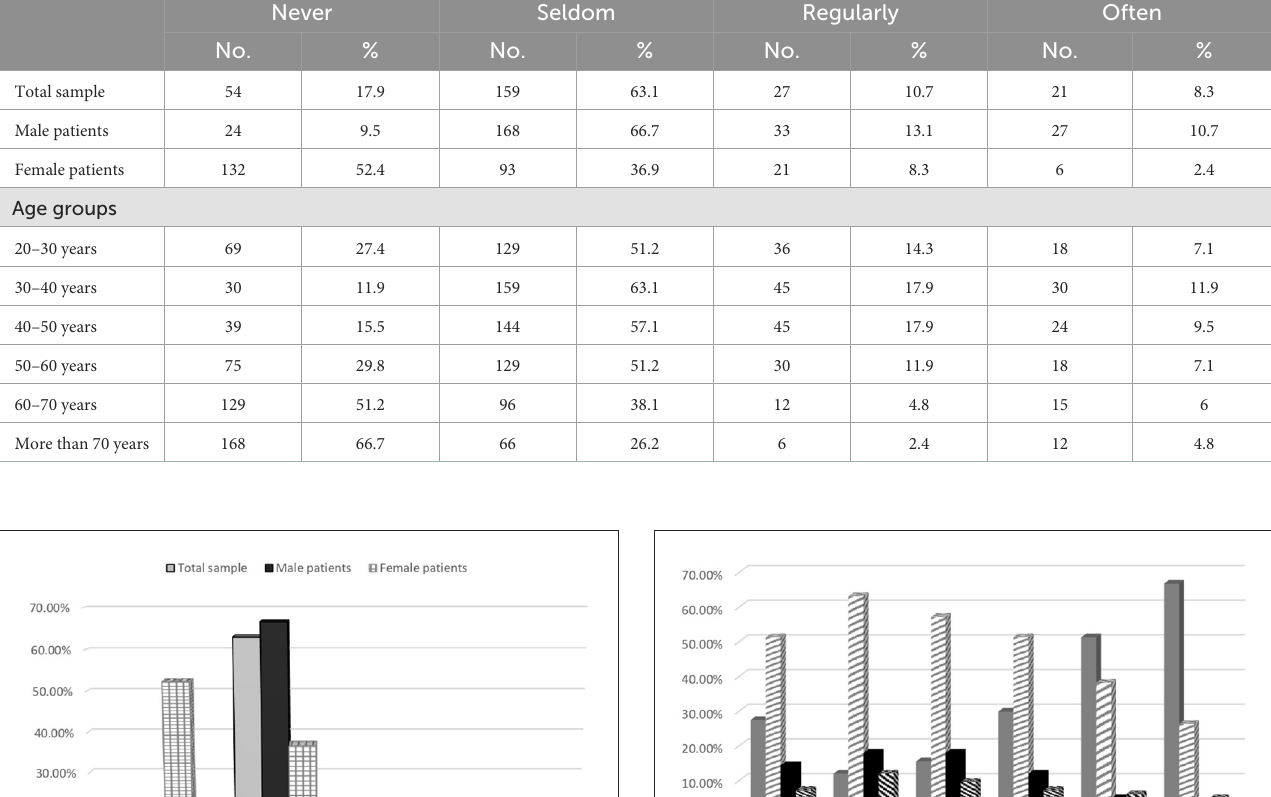
TABLE 2 Discussing sexuality with patients with neurological disease, total results, and results in subgroups according to gender and age. Never